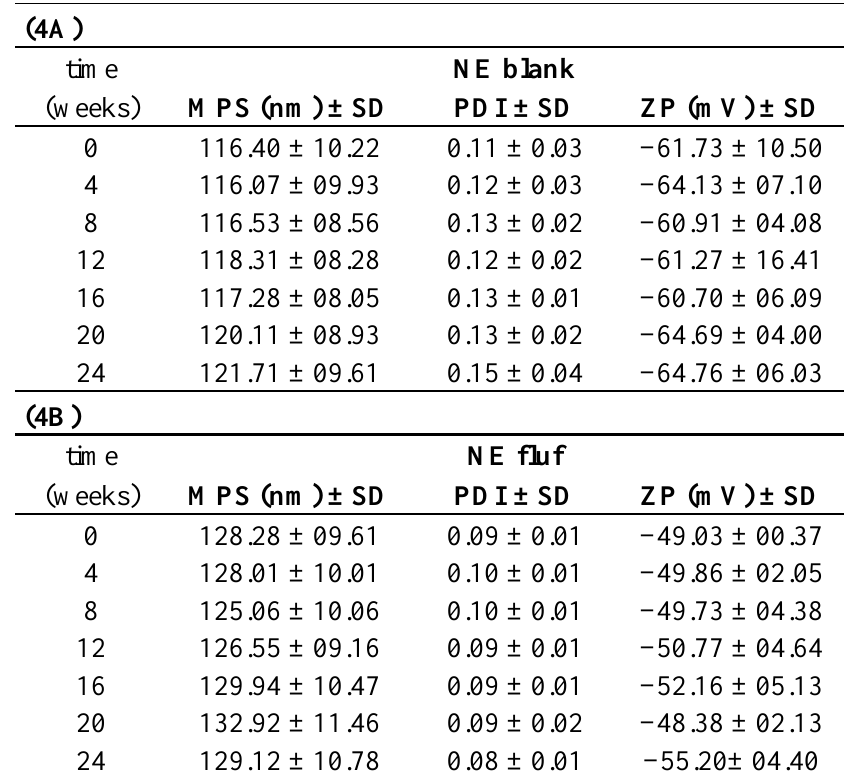
Table 4. Physical stability of blank (4A) and drug-loaded nanoemulsions ( 4B , shown on systems containing flufenamic acid). Similar results were obtained for all drug-loaded formulations. Experiments were performed in triplicate (n = 3) in regular intervals over an observation period of six months. The indicated parameters are the mean particle size (MPS), polydispersity index (PDI) and zeta potential (ZP). Numbers are given as means ±